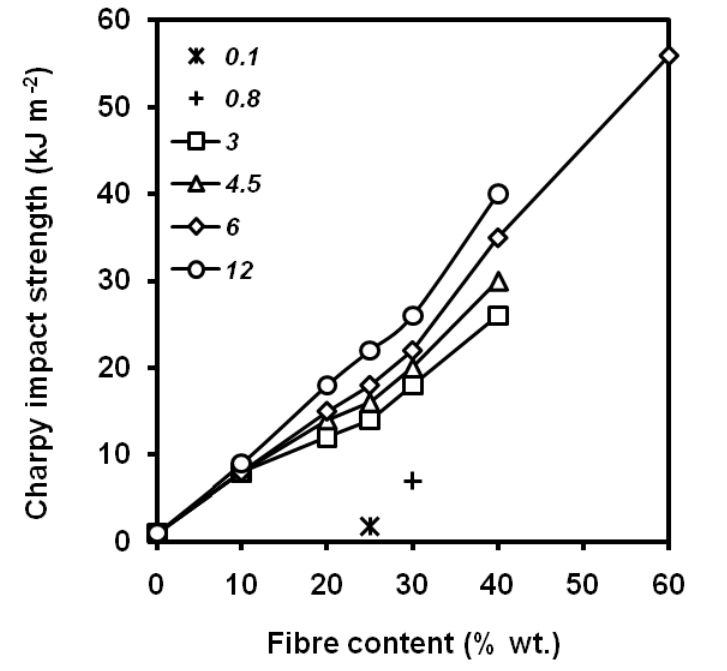
Figure 35. Influence of short glass fibre content and fibre diameter (0.1-12 mm) on notched Charpy impact strength of PP/short glass fibre composites (adapted from